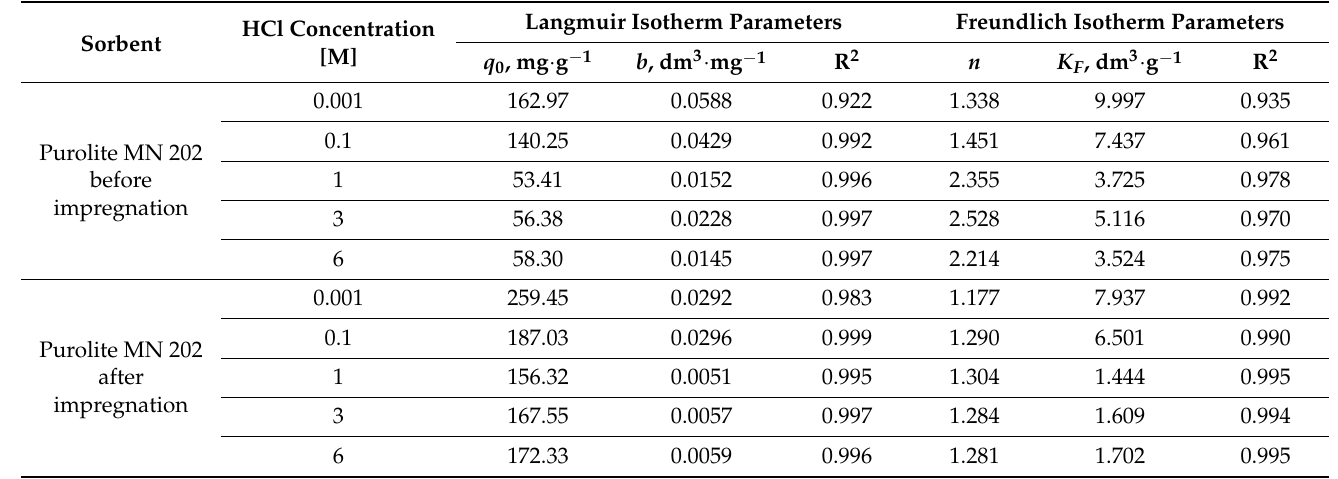
Table 2. Adsorption isotherm constants for Purolite MN 202 before and after the impregnation by Cyanex 272 determined from the linear analysis using the Langmuir and Freundlich isotherm